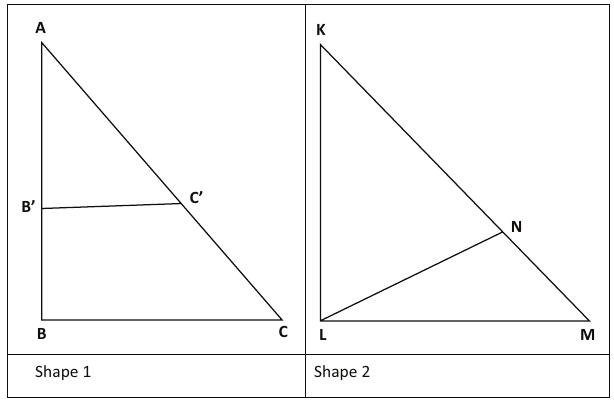
FIGURE 1: Shapes requiring different mental